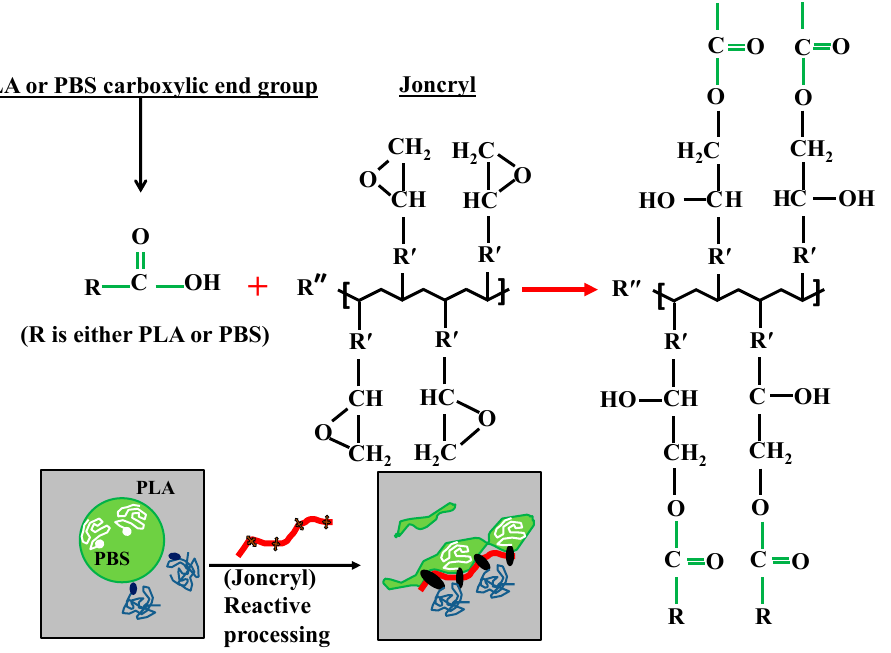
Figure 4. Schematic presentation of possible chemical reaction and formation of linear chain branched at the interface.